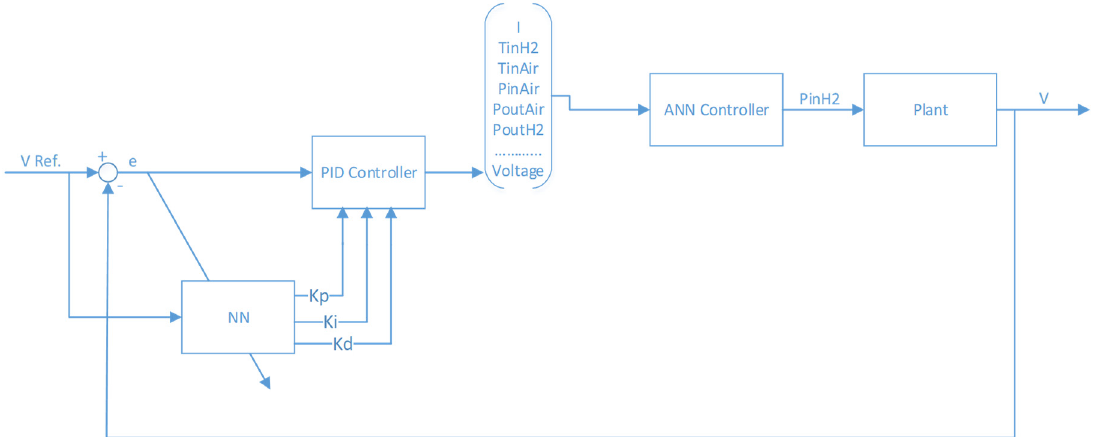
Figure 11. Proportional–integral–derivative (PID)-series neuro controller.